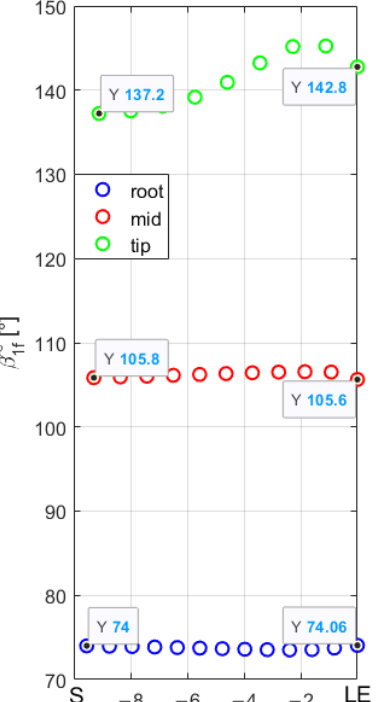
Figure 13. Linear dependence of the angular difference Δ𝛽(cid:3560) (cid:2869)(cid:3033) at the root bucket profile.